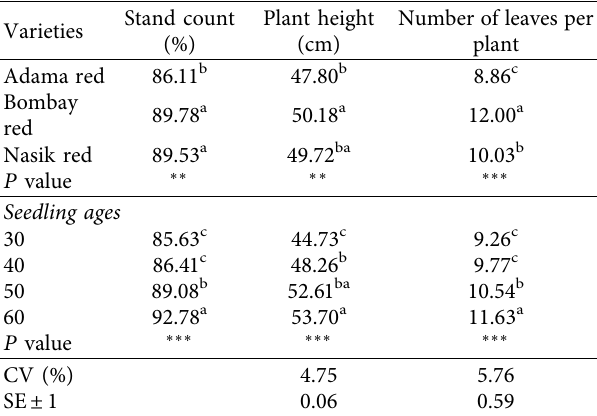
Table 3: Efect of variety and seedling age on growth parameters of